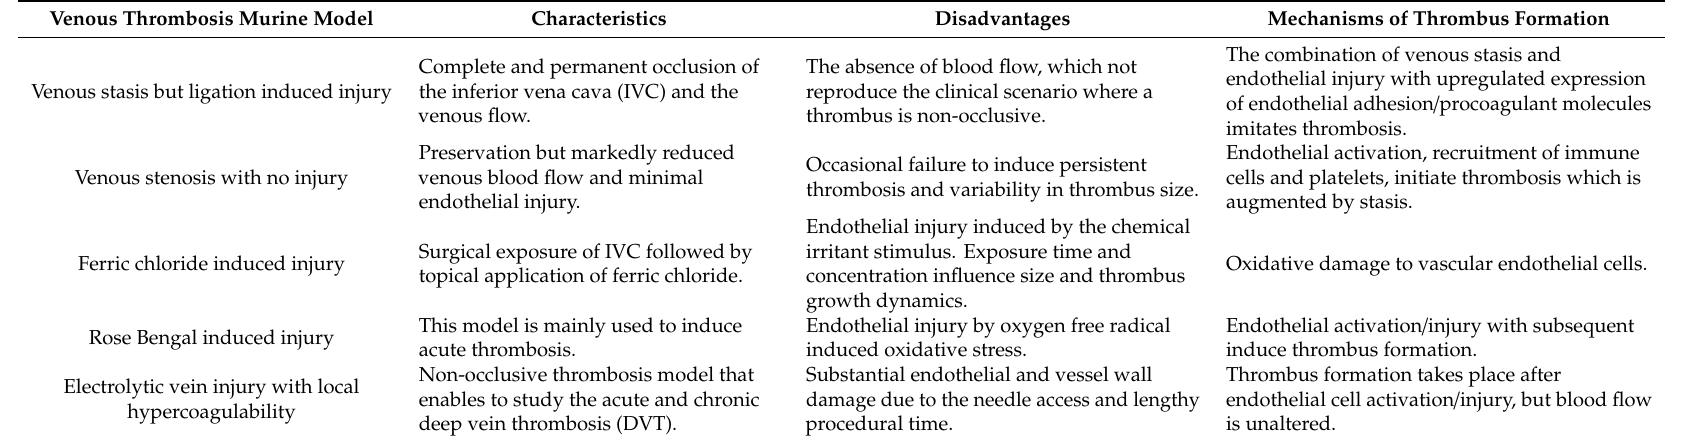
Table 1. Venous thromboembolism (VTE) mouse